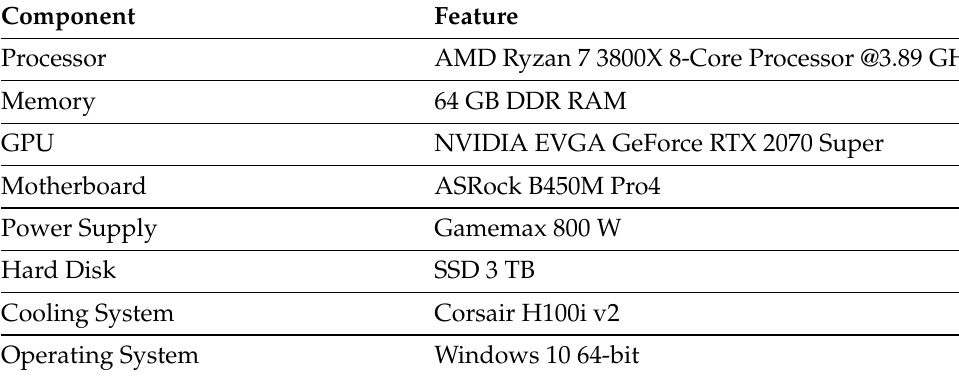
Table 5. Gaming computer